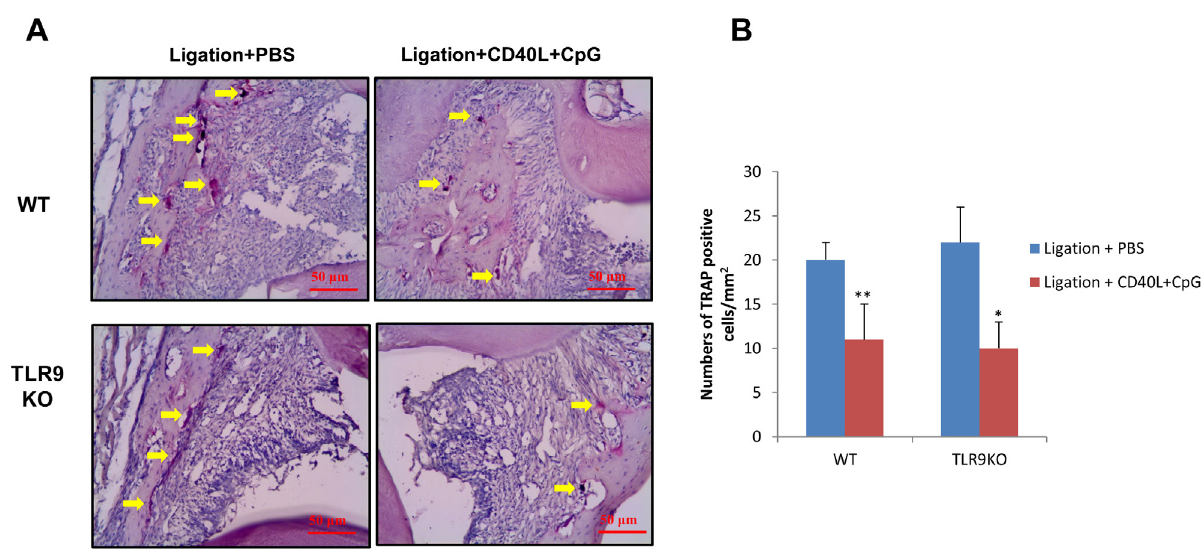
Figure 6- CpG+CD40L reduced TRAP positive cells loss in ligature-induced experimental periodontitis of WT and TLR9 KO mice. Silk ligatures were tied around the maxillary secondary molars on day 0 and injection of CpG (1 μM)+CD40L (0.1 μg/ml) or PBS was performed in palatal gingiva on days 3, 6 and 9 in WT mice and TLR9 KO mice. TRAP staining was performed on periodontal tissues and images were analyzed at a magnification of 200X (A). Bar charts showed the mean numbers of multinucleated TRAP-positive cells along the